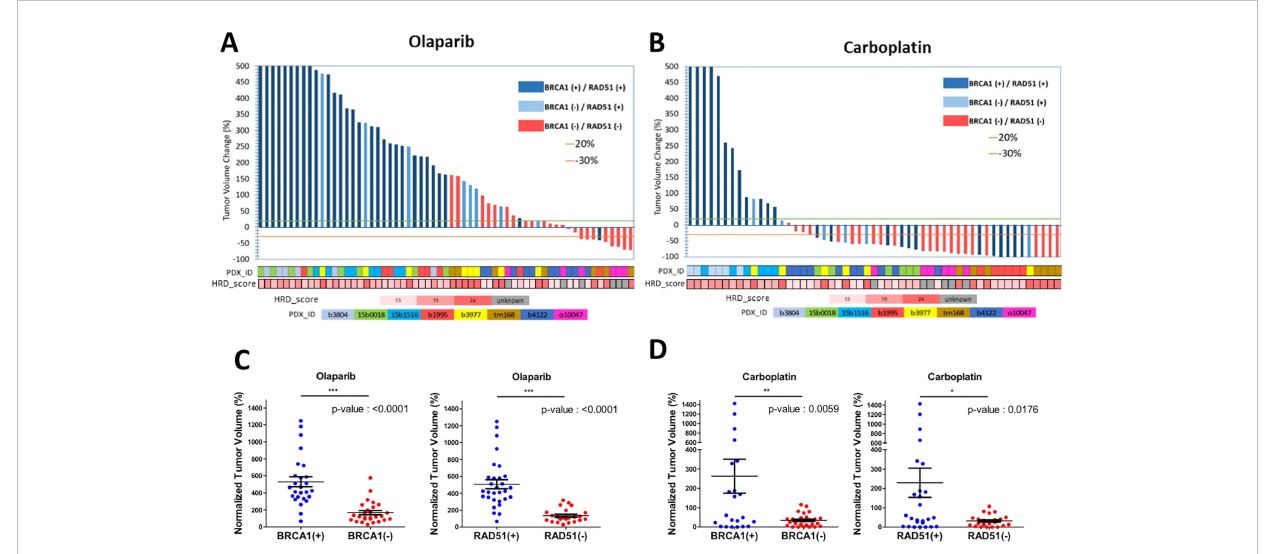
FIGURE 6 BRCA1 and RAD51 scores are good predictors of olaparib and Carboplatin response. Waterfall plots of the tumor volume change in individual PDX models (percentage of the starting volume) treated with either olaparib or Carboplatin. The status according to BRCA1 and/or RAD51 foci formation of each model is indicated by the color of the bar; dark blue BRCA1+/RAD51+; light blue BRCA1-/RAD51+; red BRCA1-/RAD51-. The identity of the PDX model is indicated by color boxes at the bottom of the graph. (A) olaparib treated mice. (B) Carboplatin treated mice. (C) tumor volume change under olaparib treatment strati fi ed according to the BRCA1 foci status. (D) tumor volume change under olaparib treatment strati fi ed according the RAD51 foci status. *, **,*** on top of the graph indicate the level of signi fi cance of the t-test.